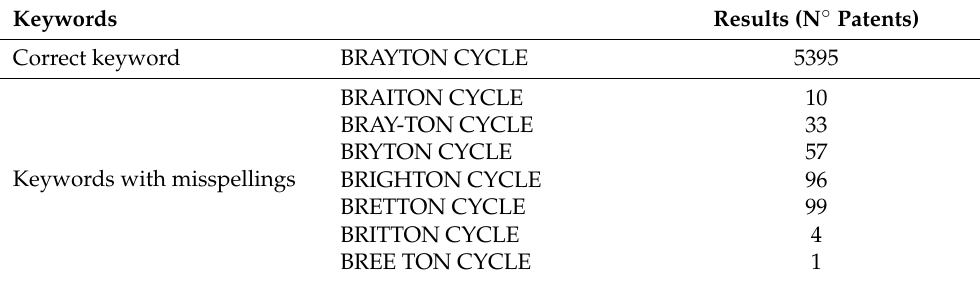
Table 4. Keywords (correct and with misspellings) used to search patents about BRAYTON